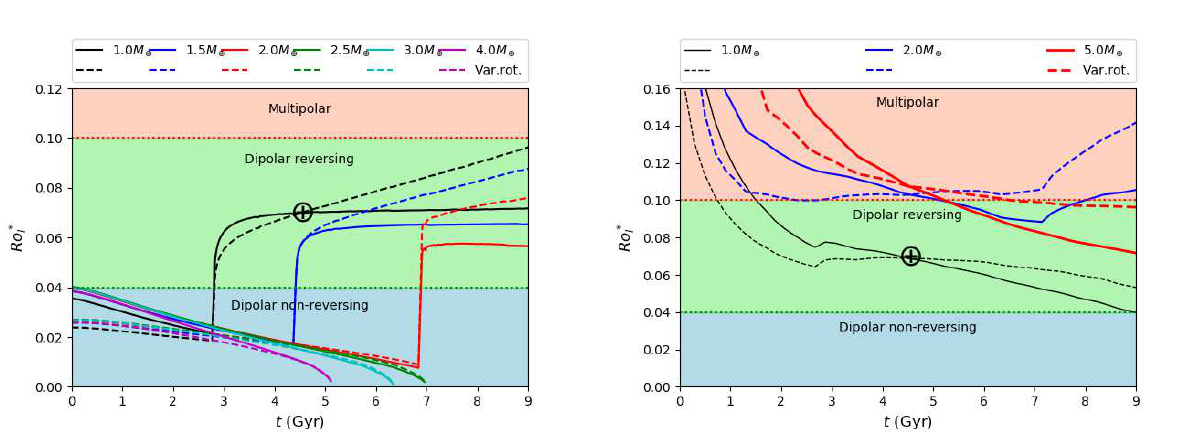
Figure 12. Evolution of the local Rossby number computed from selected results for CTE and MTE. Solid curves correspond to constant pe- riod of rotation, dashed lines correspond to a variable period. Earth-like values were assumed, i.e. P (dashed lines) dP / dt = 1.5 h Gyr −1 . Shaded regions corresponds to dynamo o